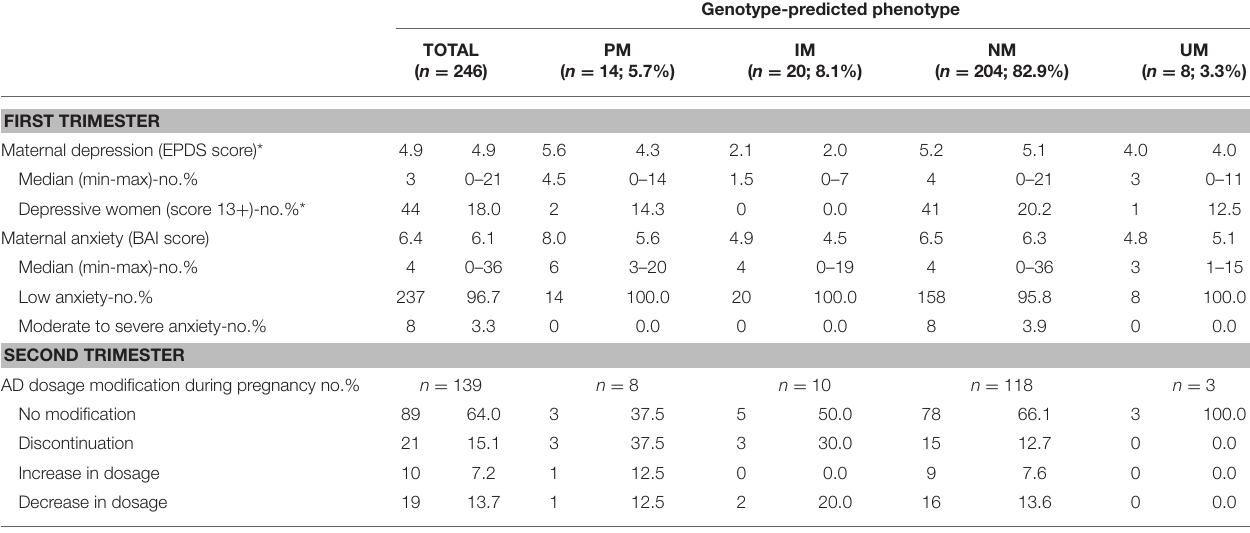
Genotype-predicted phenotype